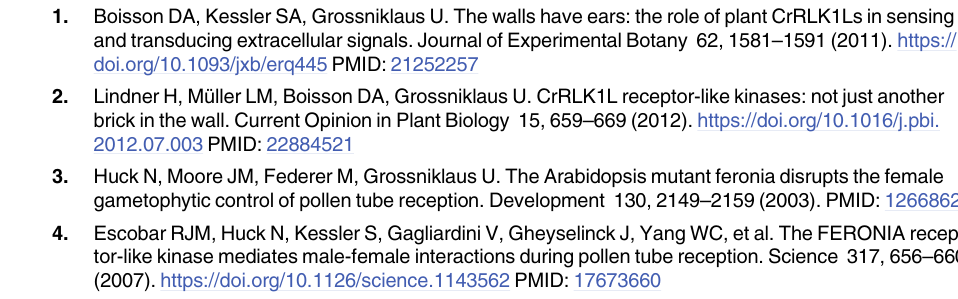
S1 Table. Primers used in this